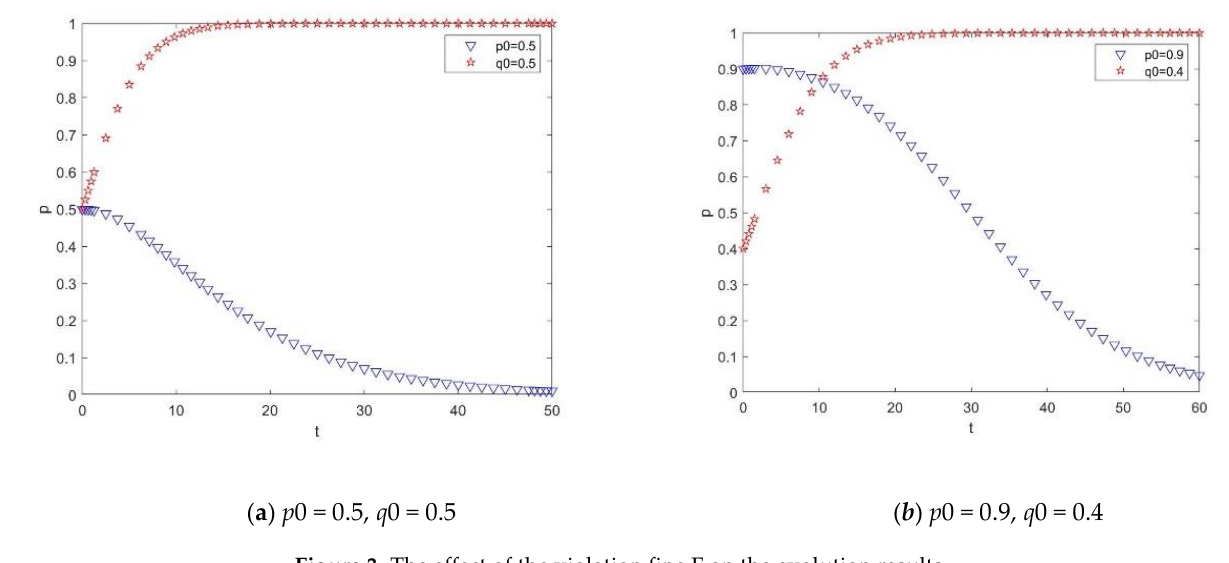
Figure 3. The effect of the violation fine F on the evolution results.